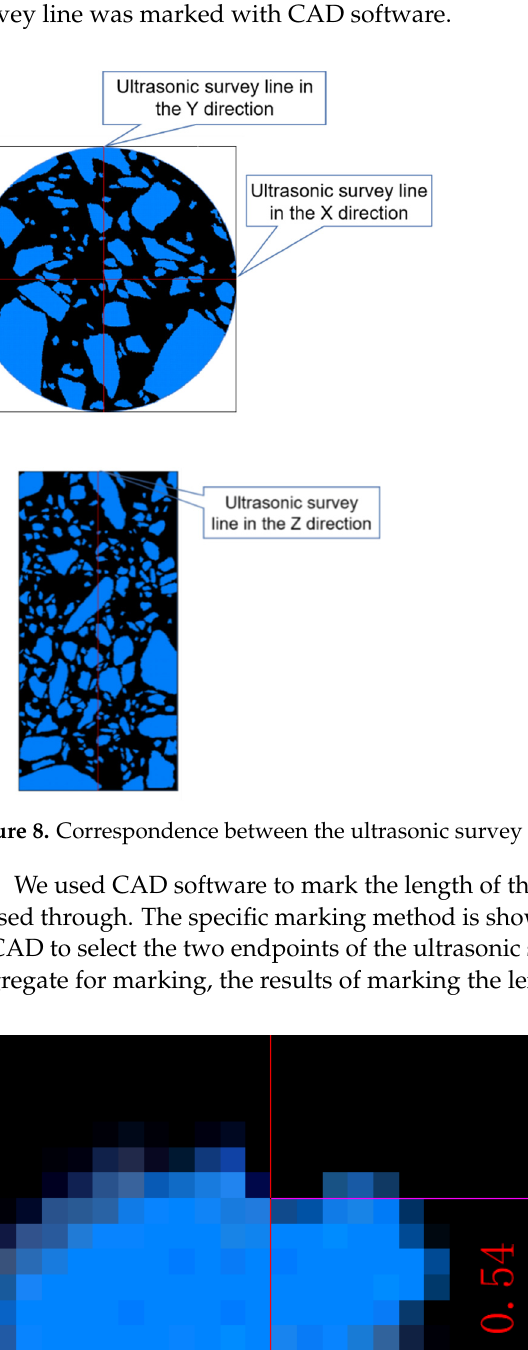
Figure 10. Schematic diagram of marking the length of coarse aggregate on ultrasonic measuring line (mm). The proportion of coarse aggregate on the ultrasonic survey line was obtained as shown in Table 6 Table 6. The proportion of coarse aggregate on the ultrasonic survey line. Direction